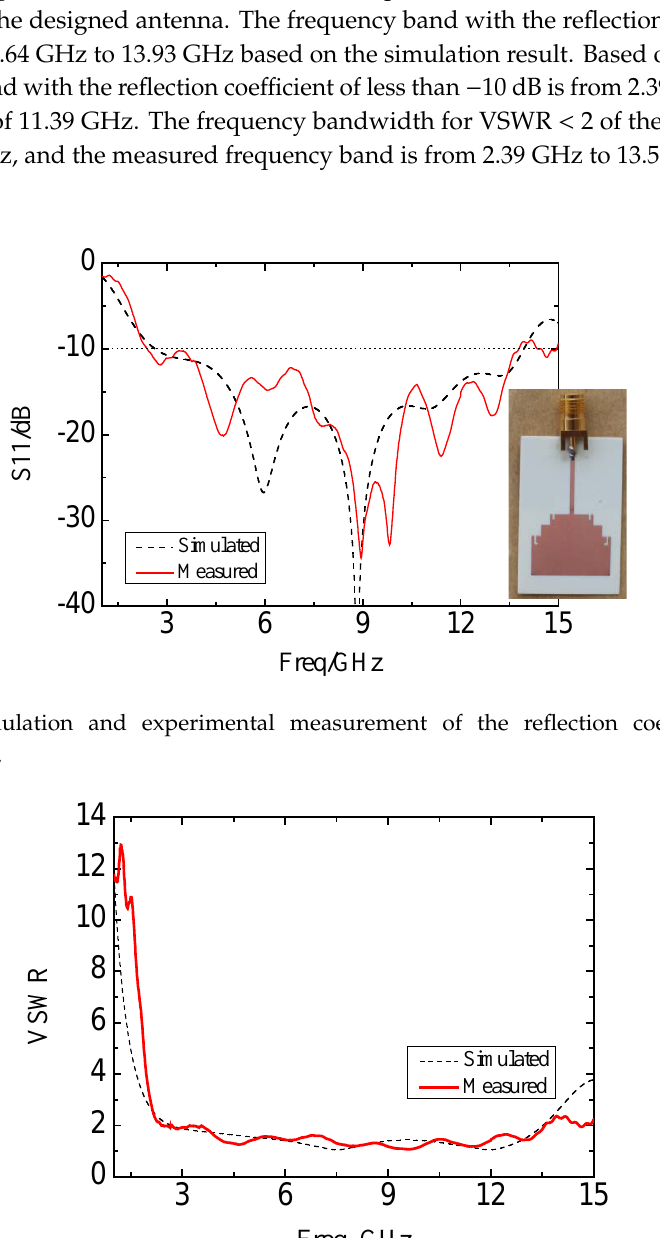
Figure 14. Simulation and experimental measurement of voltage standing wave ratio (VSWR) of the proposed antenna.